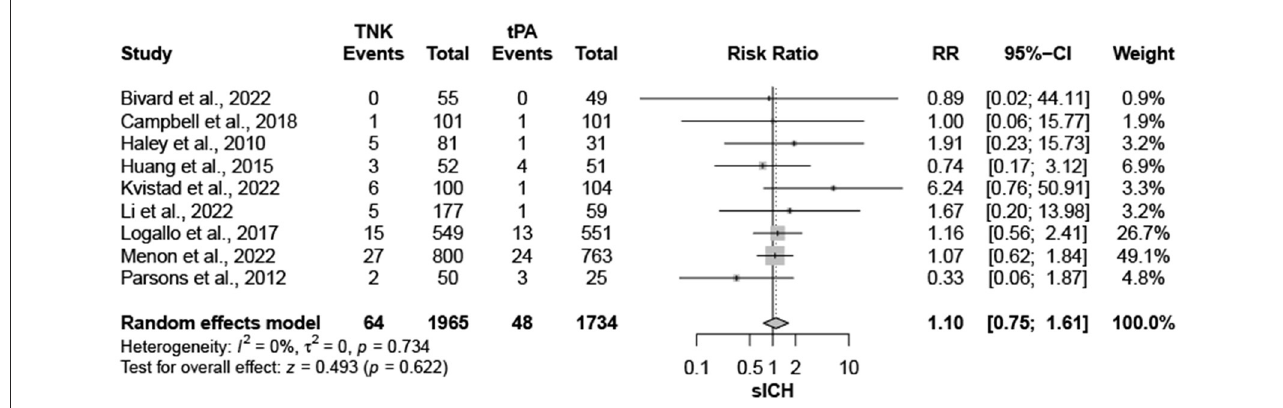
FIGURE4 Rates of sICH. TNK, tenecteplase; tPA, alteplase.